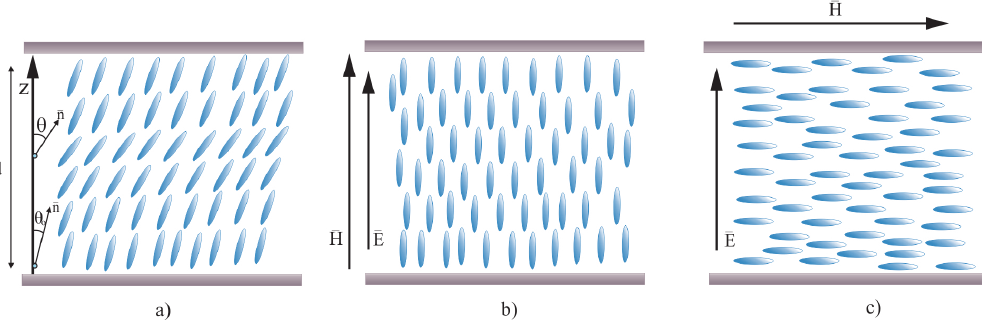
Figure 4. The orientation of nematic liquid crystal molecules in the sample cell: ( a ) initial conditions ( b ) ε (cid:107) measurement ( c ) ε ⊥ measurement. Here, n is the director, θ is the angle between the director and the z axis, and θ 0 is the pretilt angle on the surfaces of the